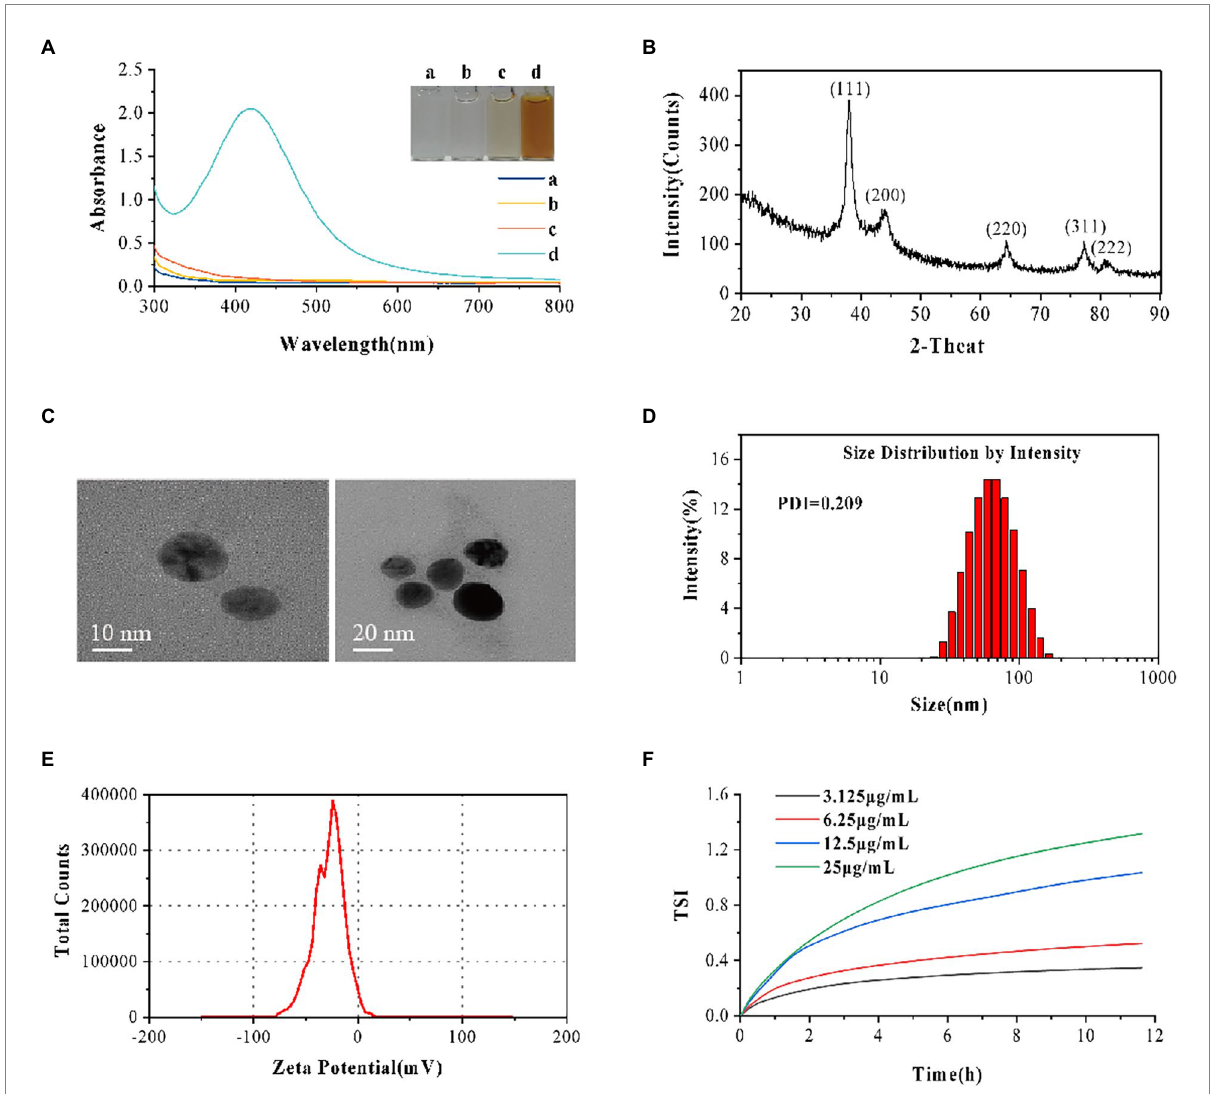
FIGURE 1 AVH-AgNPs characterization. (A) The Ultraviolet–visible spectroscopy (UV–vis spectra) demonstrated a strong absorption peak at 400–450 nm for AVH-AgNPs (a: AgNO 3 , b: H 2 O, c: AVH, d: AVH-AgNPs); (B) X-ray diffraction (XRD) analysis graph revealed the highest peak matching with the crystal planes of elemental silver; (C) The Transmission Electron Microscope (TEM) showed that AVH-AgNPs particles were spherical and well- dispersed; (D) Size distribution graph showed good dispersibility; (E) Zeta potential analysis observed − 27.9 ± 4.3 mV with good stability and (F) Turbiscan stability index (TSI) adequately demonstrated the highly stable